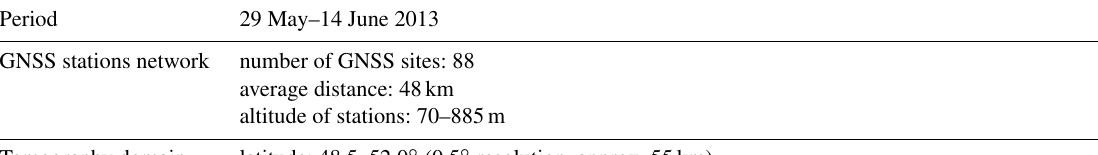
Table 3. Applied tomography model settings.